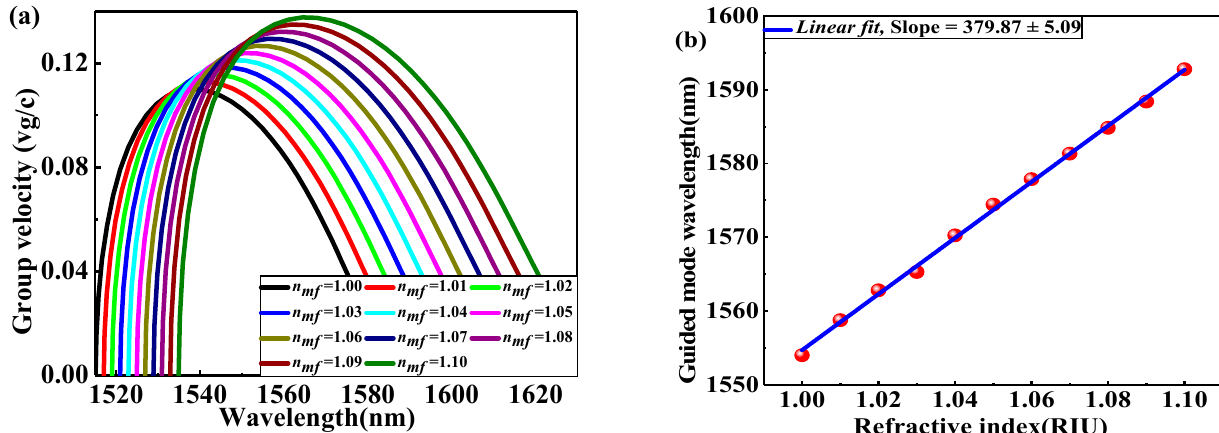
Figure 4. ( a ) Group velocity v g / c as a function of wavelength due to changing RI of n mf from 1.00 to 1.10 with an increment of ∆ n mf = 0.01, ( b ) the selected guided mode wavelength for each value of n mf . Table 2. Comparison of RI sensitivity in EPCW with previous studies based on the conventional PCW.